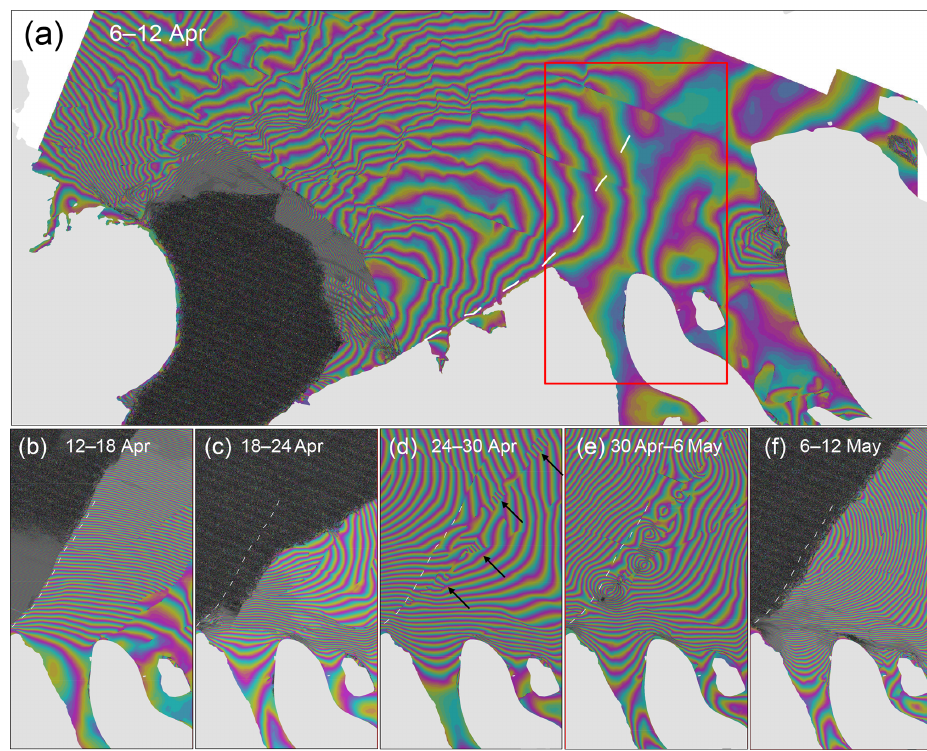
Figure 11. Interferogram over the Nares Strait ice arch in 2017, covering the time period 6–12 April (a) . Smaller panels show consecutive interferograms within the box for 12–18 April (b) , 18–24 April (c) , 24–30 April (d) , 30 April–6 May (e) , and 6–12 May (f) . Dashed line represents the line separating fast and moving ice in Fig. 12c. The black arrows in (d) indicate fringe patterns further discussed in the text. Land is masked out in light